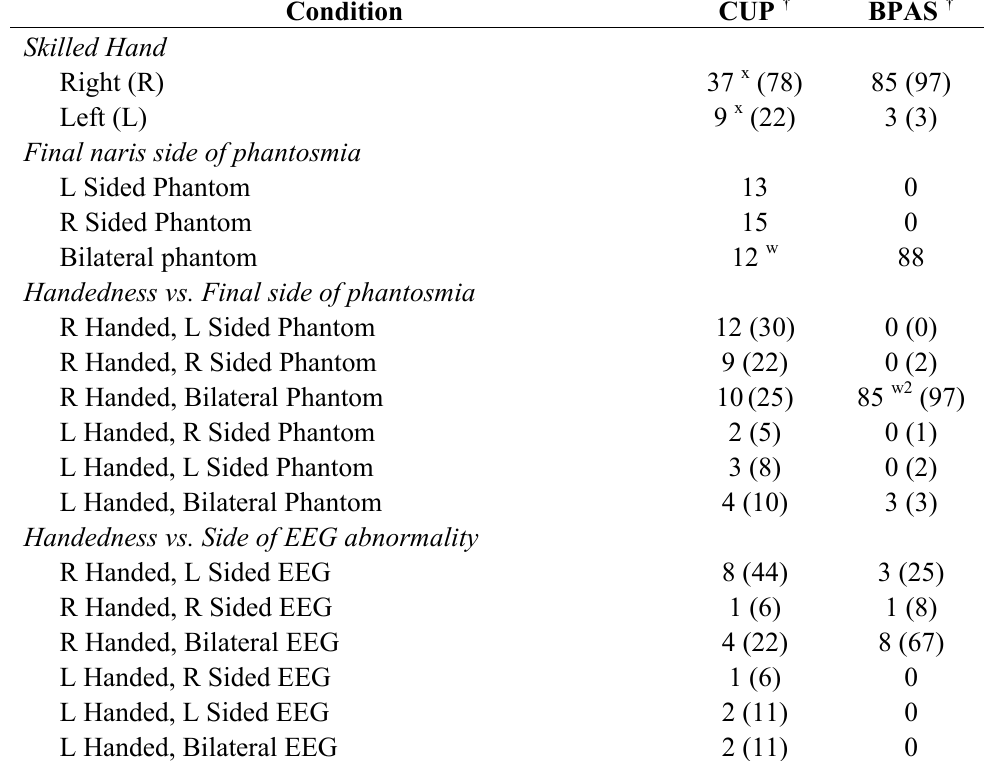
Table 8. EEG characteristics in patients with